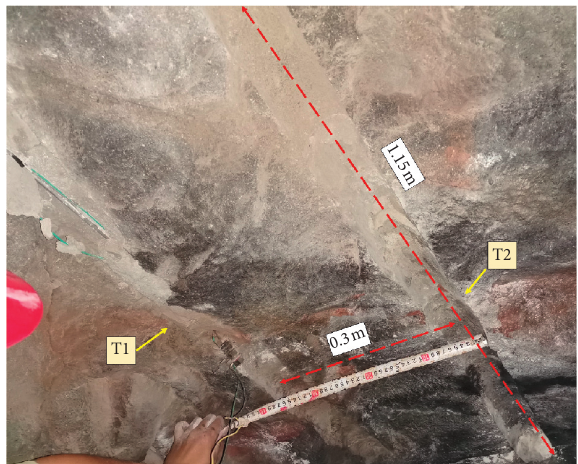
Figure 9: Initial rock fracturing effect on vault.